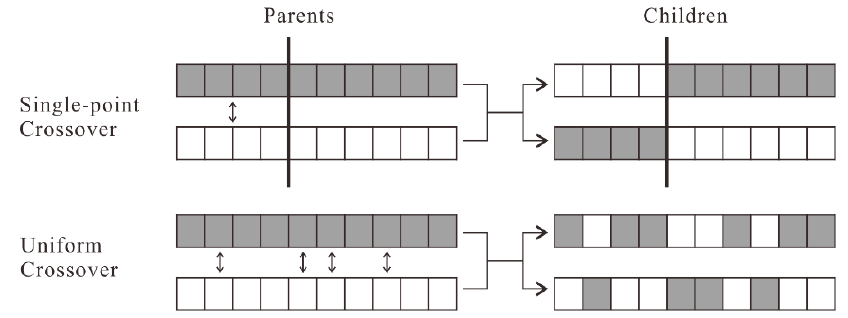
Figure 7. Single-point crossover and uniform crossover.